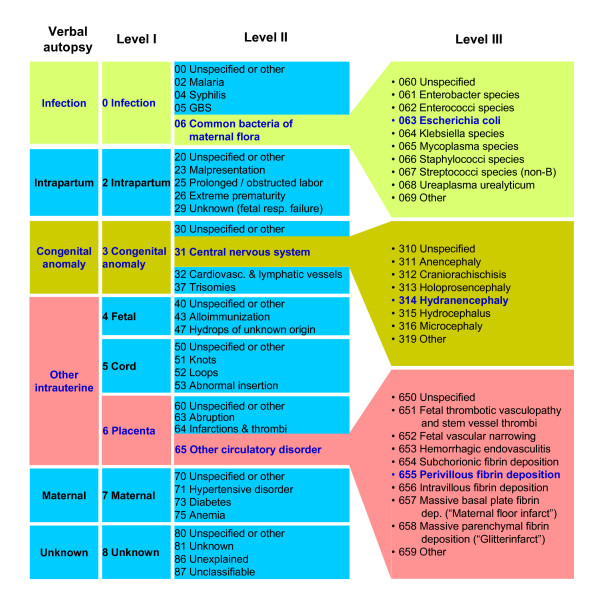
Causes of death in stillbirth. Expandable layers of causes of death according to the resources available for evaluations of stillbirths. Select categories of the CODAC classification system [50] used for illustration.